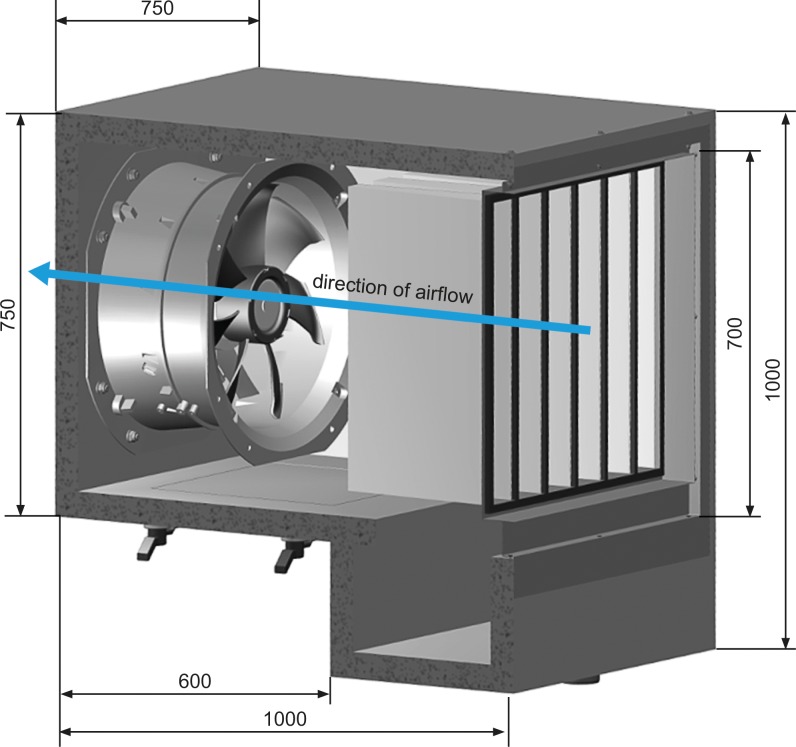
Cross section of a recirculating air filter module from barn 4.Each recirculating air filter module consisted of a plastic housing equipped with a pocket air filter and a fan. The air volume flow rate was regulated via the fan. Module dimensions (mm) are specified and the direction of airflow is indicated by a blue arrow. Barn 4 was equipped with four of these modules.